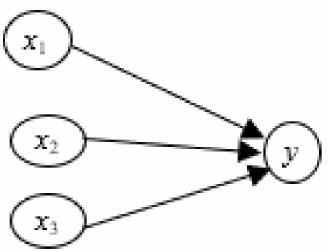
Figure 1. A sample portion of the FCNN model.